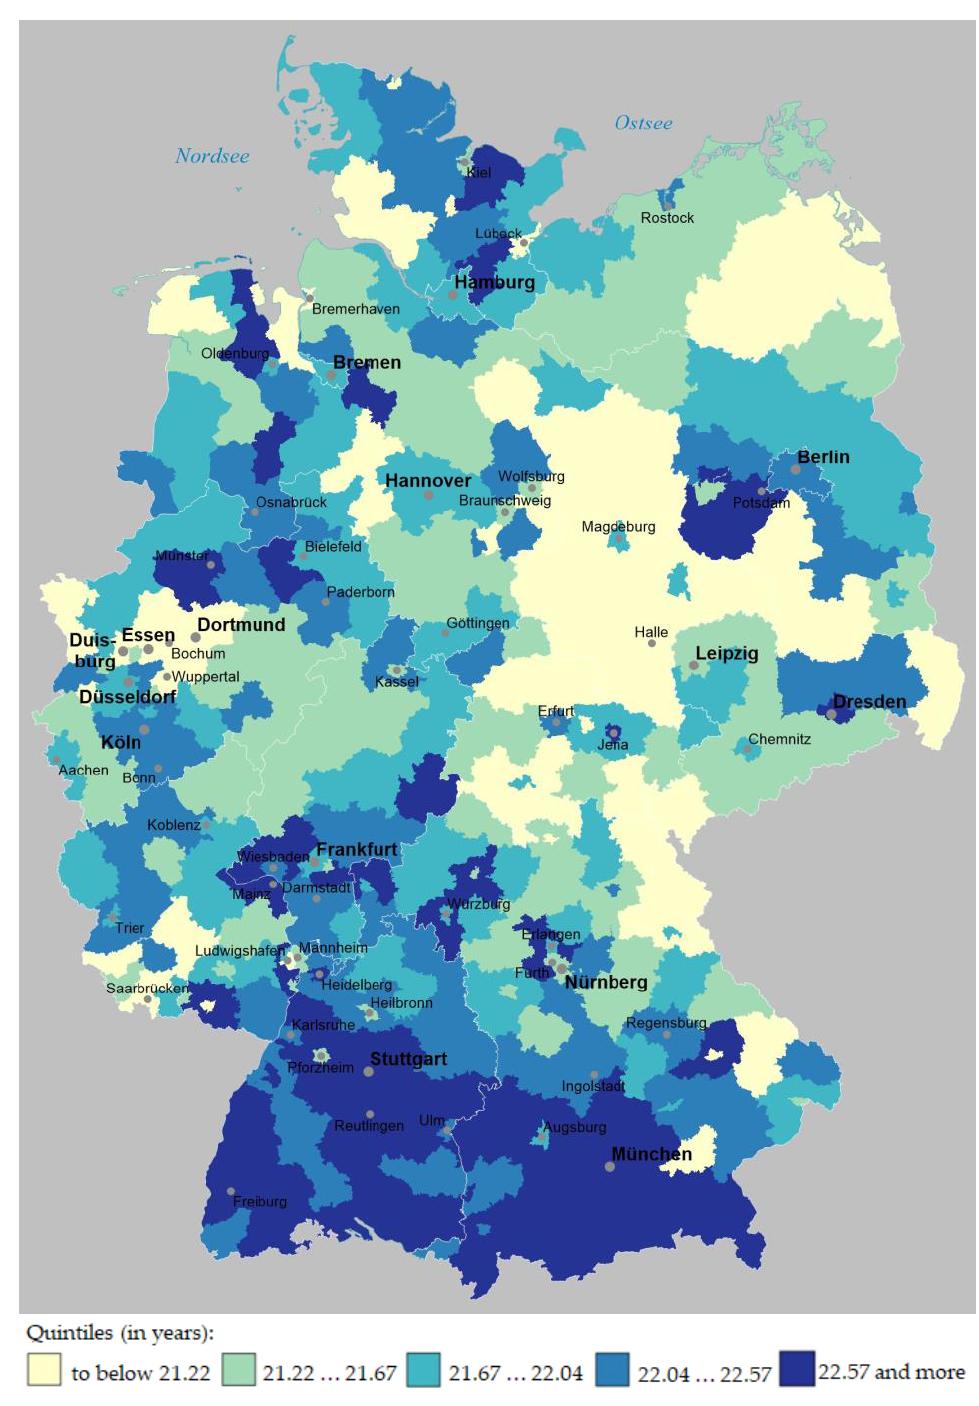
Figure 1. Men’s remaining life expectancy at age 60 at district level in Germany, grouped in quintiles and based on period life tables 2015/17.